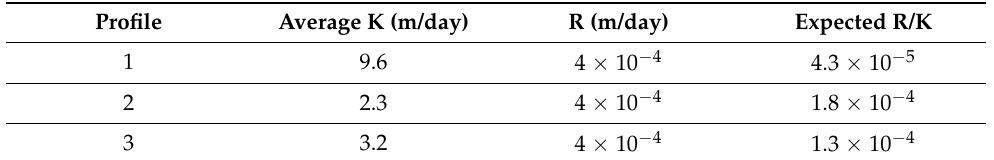
the average R/K value of the profile matched the expected R/K value.